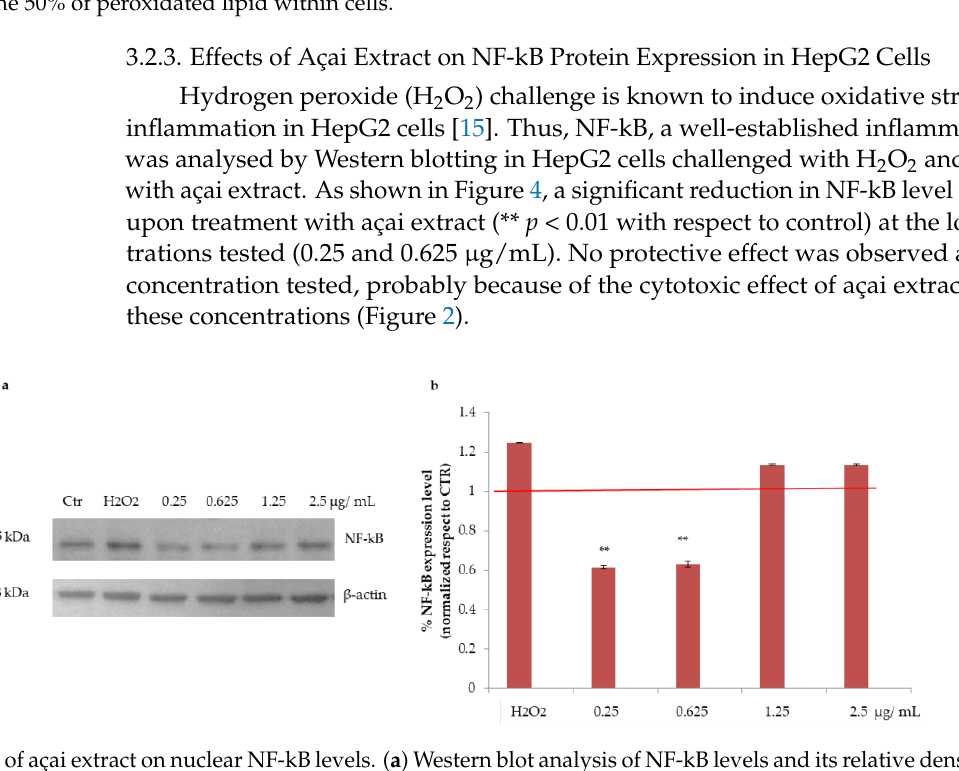
Figure 3. Effect of açai extract on lipid peroxidation in steatotic HepG2 cells pretreated with FAs. Lipid peroxidation levels were determined after 30 min incubation with H 2 O 2 (50 µM) and then incubated with açai extract at different concentrations (0.25 – 0.625 – 1.25 – 2.5 µg/mL) for 24 h. Data are means ± SD of independent experiments (n = 3). * indicates p < 0.05; ** indicates p < 0.01 with respect to H 2 O 2 pretreated cells. The red line is relative to cells pretreated to the sole FAs; the black line indicates the 50% of peroxidated lipid within cells.